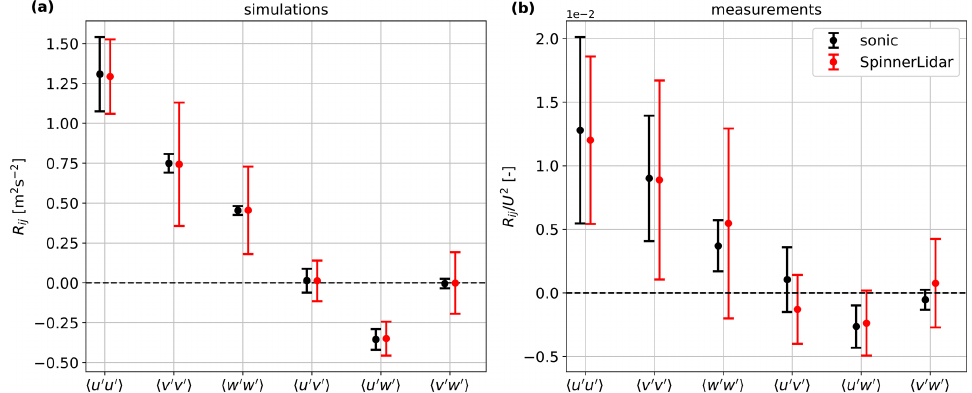
Figure 14. Reynolds stresses derived from the SpinnerLidar and sonic anemometer, (a) numerical simulations using 100 turbulence boxes and (b) measurements. The markers are the means and the error bars are ± 1 standard deviation.